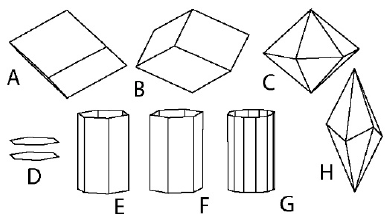
Figure 8. Crystalline forms of the 3 (cid:3364) 2/m class of the rhombohedral system, after [38]. ( A ) positive rhombohedron; ( B ) negative rhombohedron; ( C ) hexagonal dipyramid; ( D ) pinacoid; ( E ) first-order hexagonal prism; ( F ) second-order hexagonal prism; ( G ) dihexagonal prism; and ( H ) ditrigonal scalenohedron. Rubies from Mong Hsu in Myanmar show a number of di ff erent habits (Figure 9) [30,45] and are